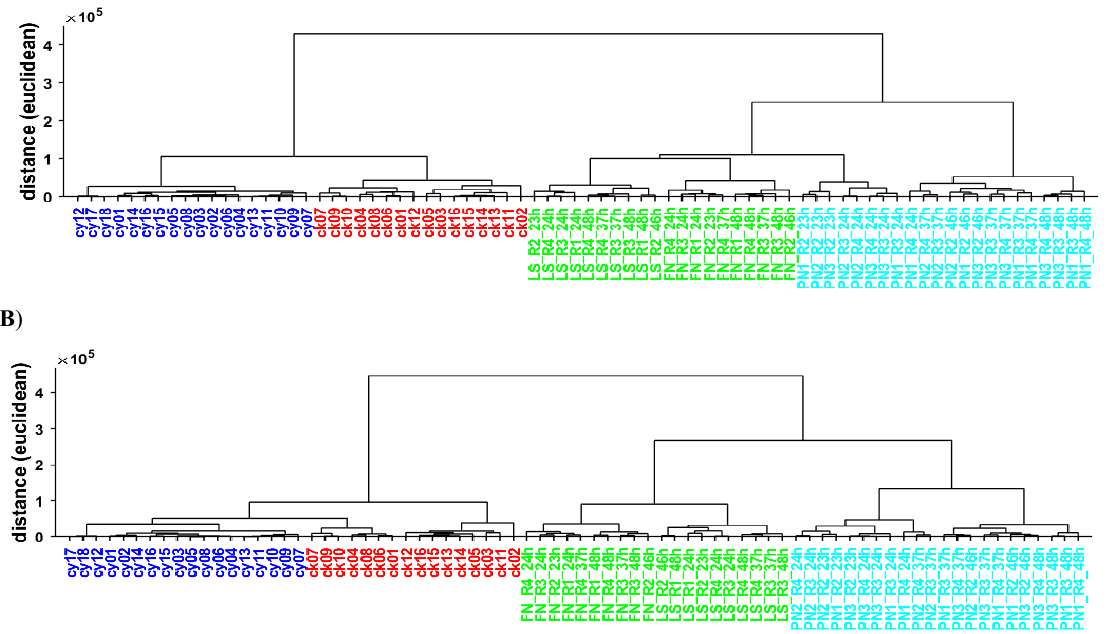
Figure 4. Dendrogram based on ( A ) PCA analysis (PC1–PC4) and ( B ) NNMF analysis (C1–C4). A detailed description of the sample data is provided in Appendix A, Tables A1–A3.